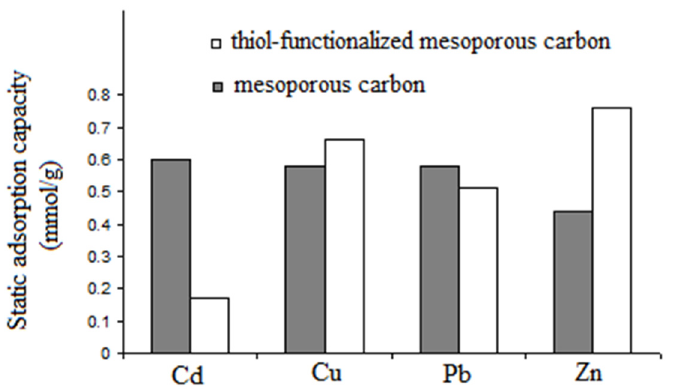
Figure 4. Static adsorption capacity of mesoporous carbon and thiol-functionalized mesoporous car ‐ bon.